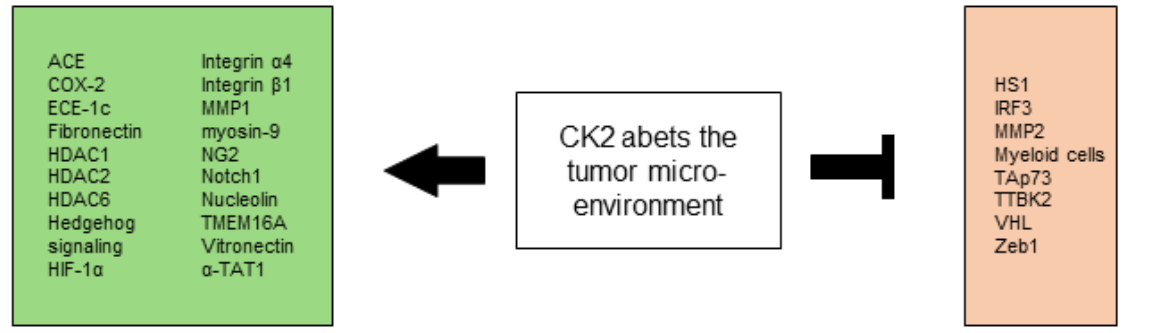
Figure 6. CK2-dependent modified proteins involved in the tumor microenvironment. Proteins that are activated in this process by CK2 modification are shown on the left (highlighted in green), and proteins that are restricted in their function are shown on the right (highlighted in red).